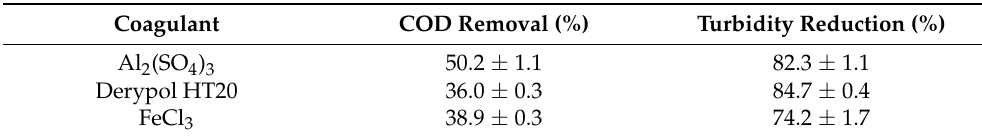
Table 5. Results obtained on COD removal (%) and turbidity reduction for the coagulation assay coagulant test.